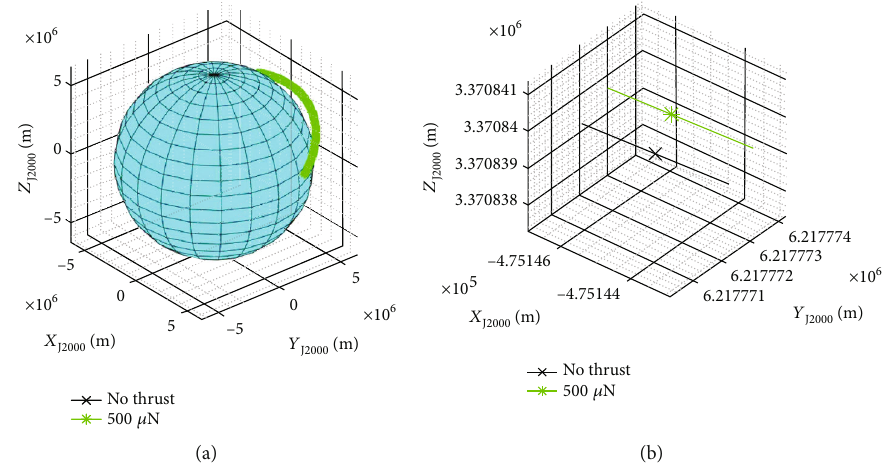
Figure 6: Three-dimensional position of the satellite orbit and partial enlarged view.